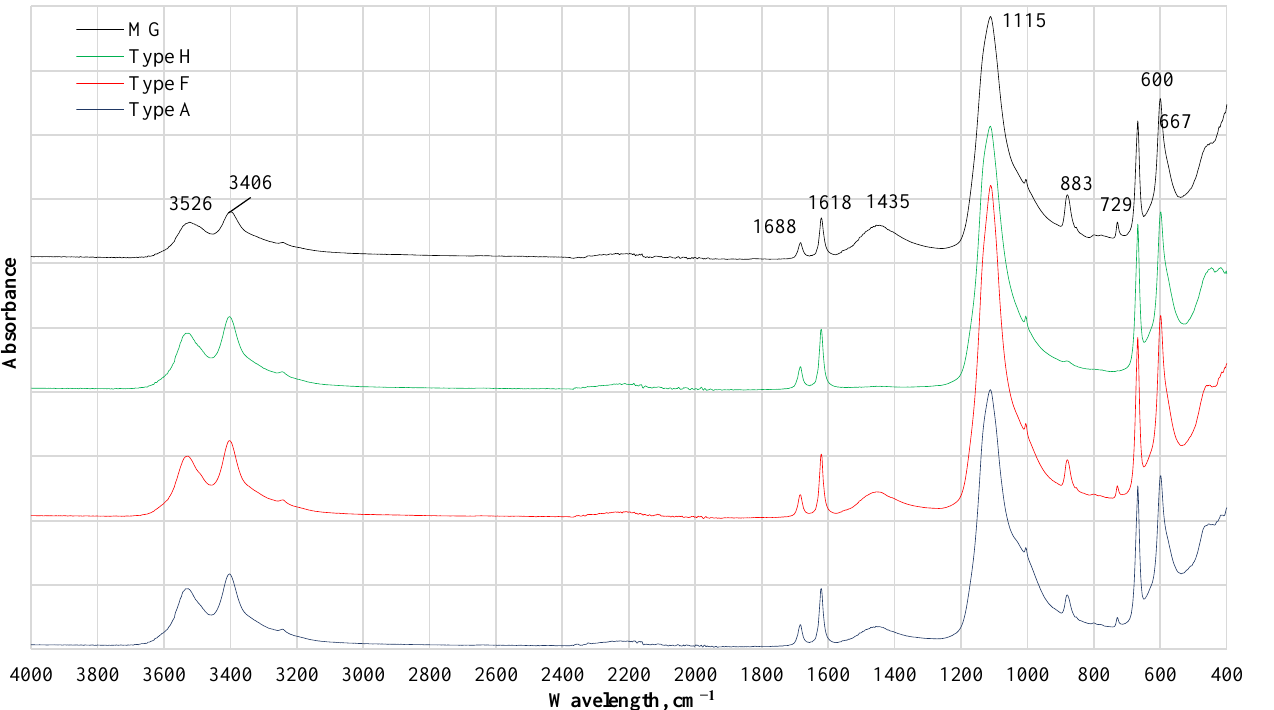
Figure 3. FTIR results of different types of gypsum CDW. MG — gypsum monolithic wall CDW; Type H — gypsum drywall, impregnated; Type F — gypsum drywall, fire-resistant; Type A — gypsum drywall, standard.